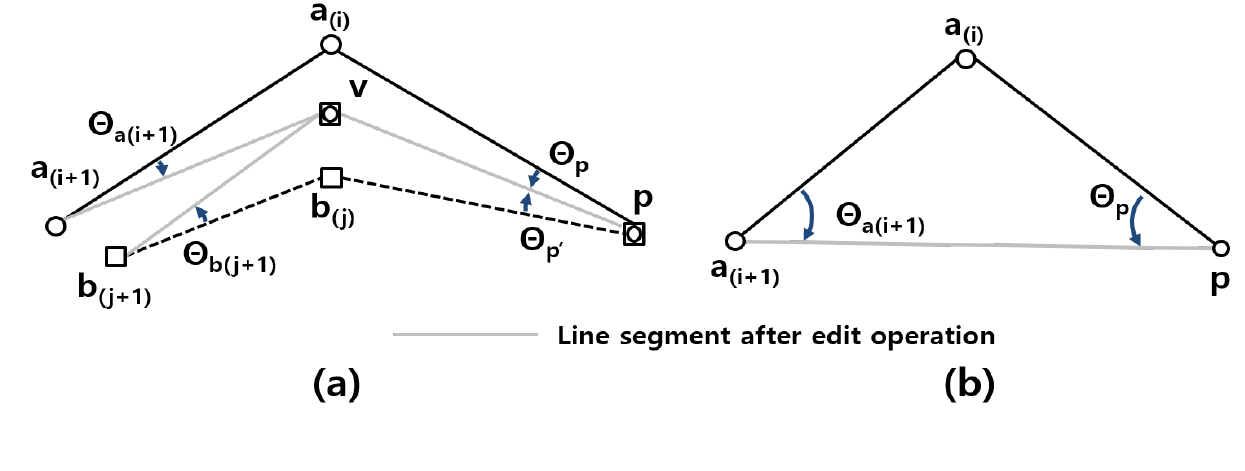
Figure 4. Cost functions of string matching in this study; ( a ) snapping operation, ( b ) removing